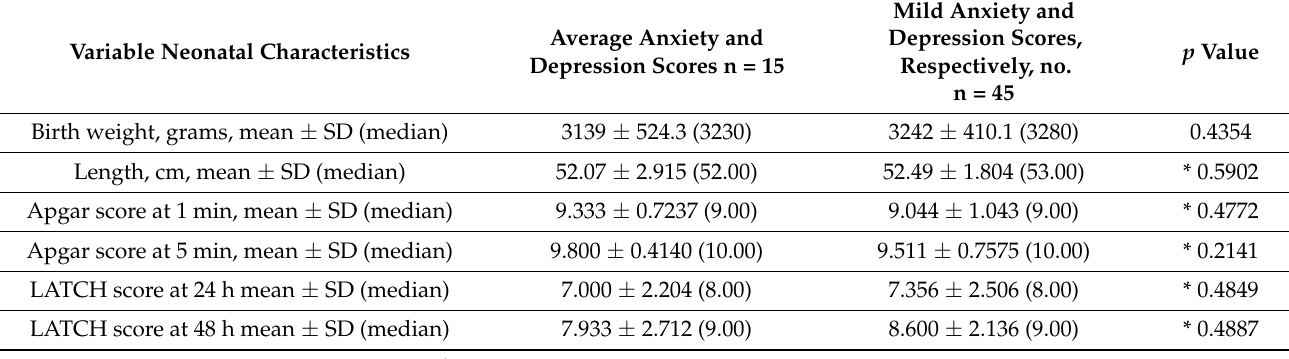
Table 5. Neonatal